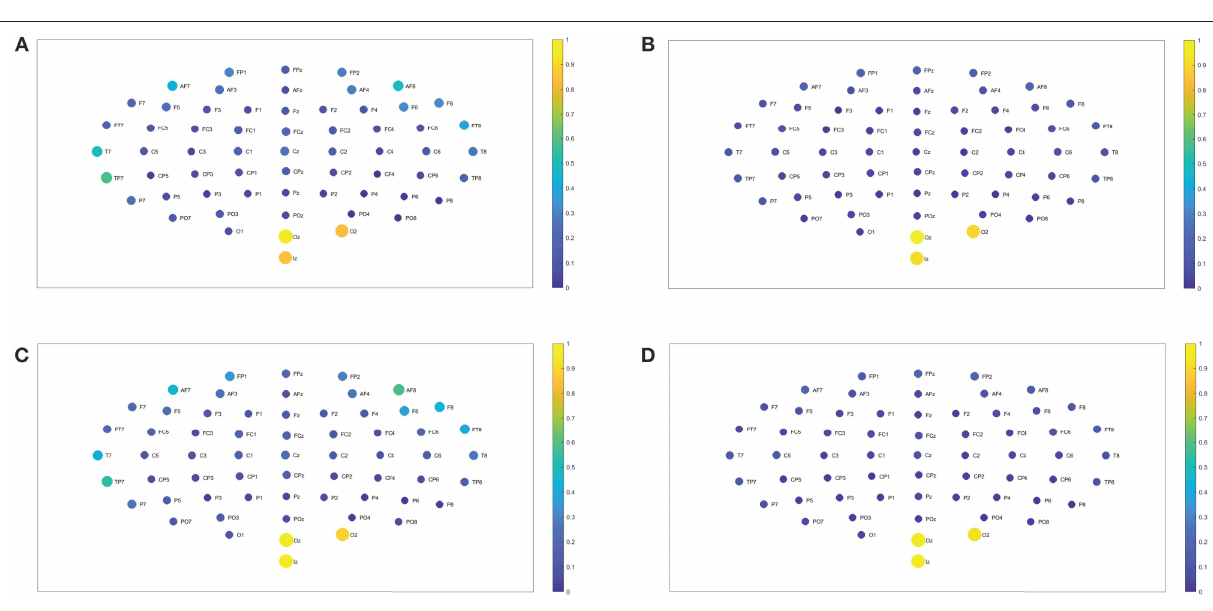
FIGURE 11 | Closeness centrality. (A,B) Show the nodes’ centrality considering 109 subjects when performing the visuomotor task for the 62-channels EEG considering the different oscillation bands gamma 1 and gamma 2. (C,D) Are the same as (A,B) but considering the imagined task. We consider D = 6 and τ = 1. Gamma 1 oscillation band corresponds to [31,41) Hz and gamma 2 oscillation band to [41,50) Hz